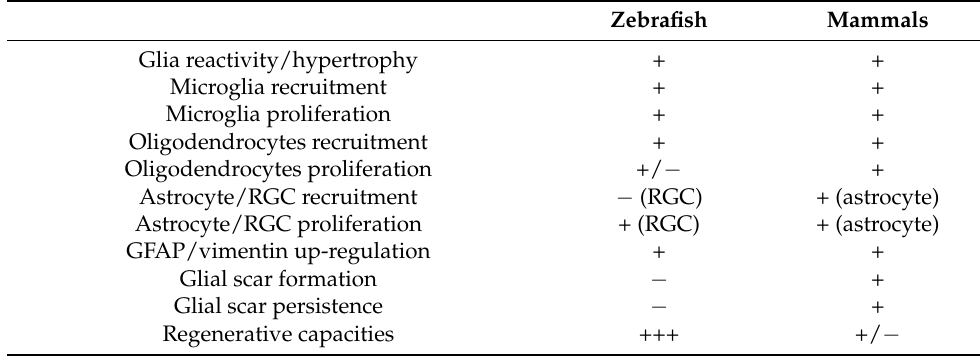
Table 3. Comparison of events after brain damage in zebrafish and mammals. +++: strong; +: present; +/ − : weak; − :